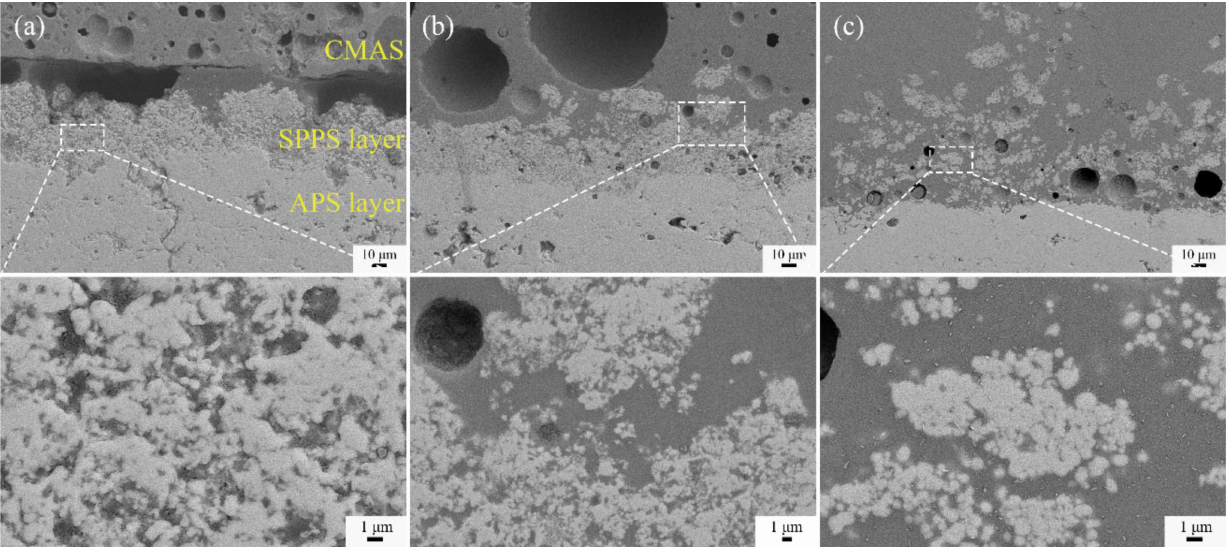
Figure 8. Interface between SPPS layers and CMAS after different times of heat treatment: ( a ) 180 s; ( b ) 300 s; ( c ) 600